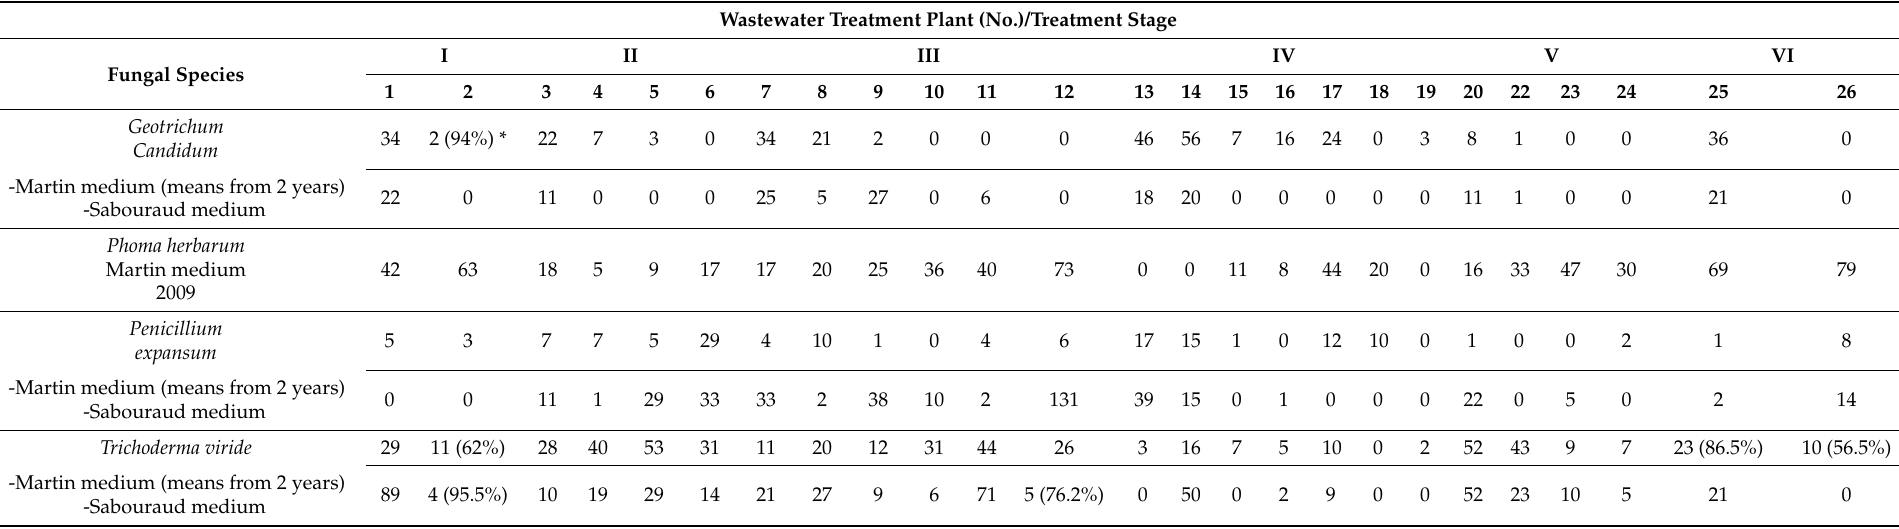
Table 8. Total numbers of the most frequent species of filamentous fungi at subsequent wastewater treatment stages; ( ) *—% reduction vs. raw wastewater; Explanation as for Table